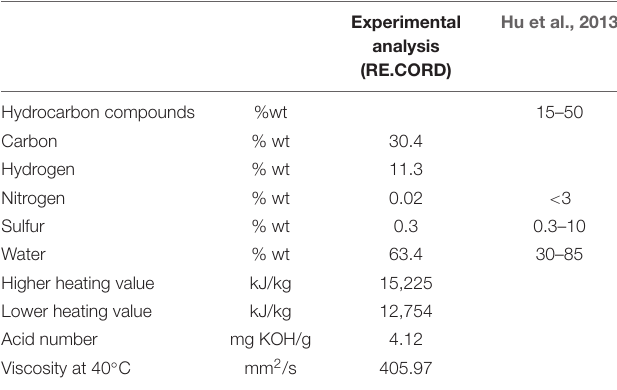
TABLE 1 | Comparison between chemical analyses carried out by RE-CORD and Hu et al. (2013).